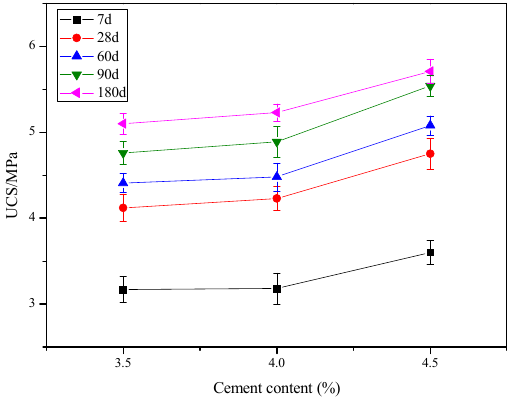
Figure 3. Relationship between the UCS and cement content.